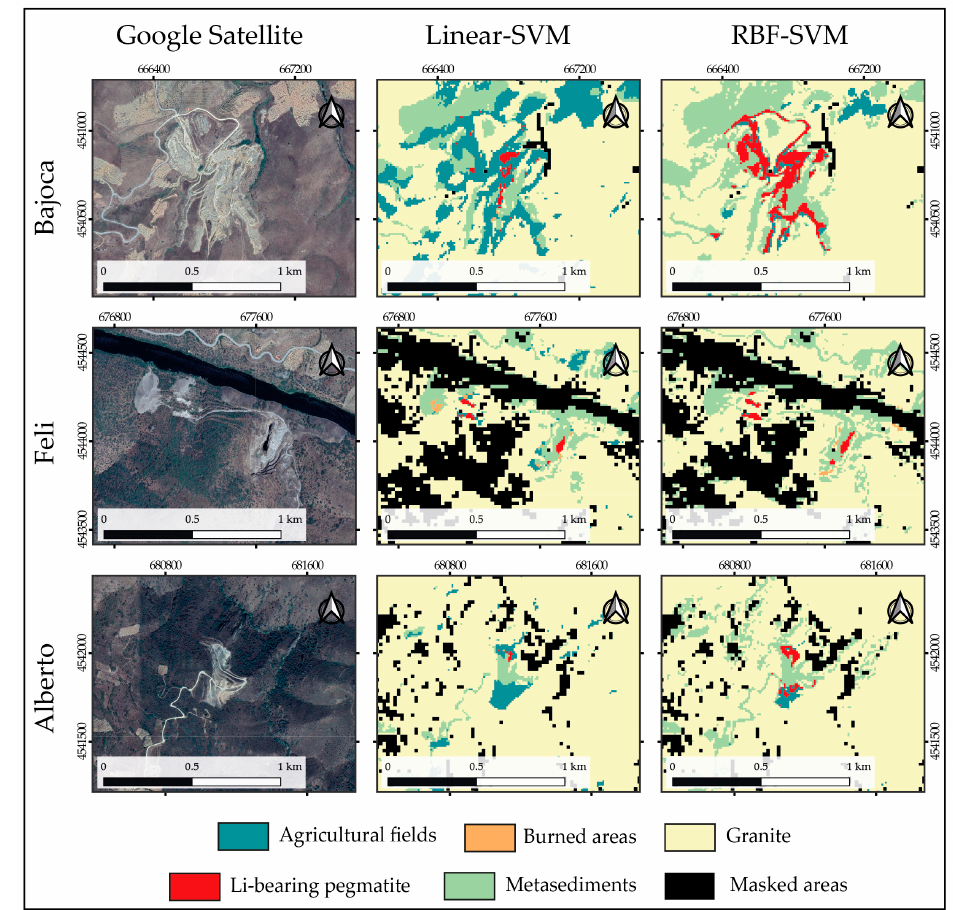
Figure 9. Evaluation of the models’ performance in the known open-pit mines exploiting Li-bearing pegmatite.